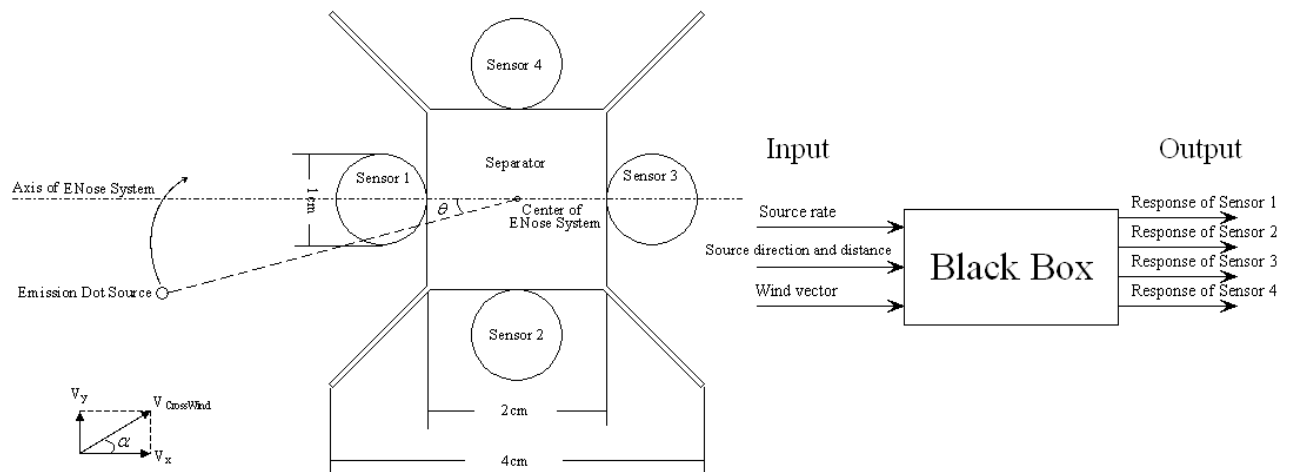
Figure 1 . Electronic nose system structure, left part is the physical structure of electronic nose, which contains 4 sensors separated by an impermeable four wings separator; the right part is the black box problem schema for the whole